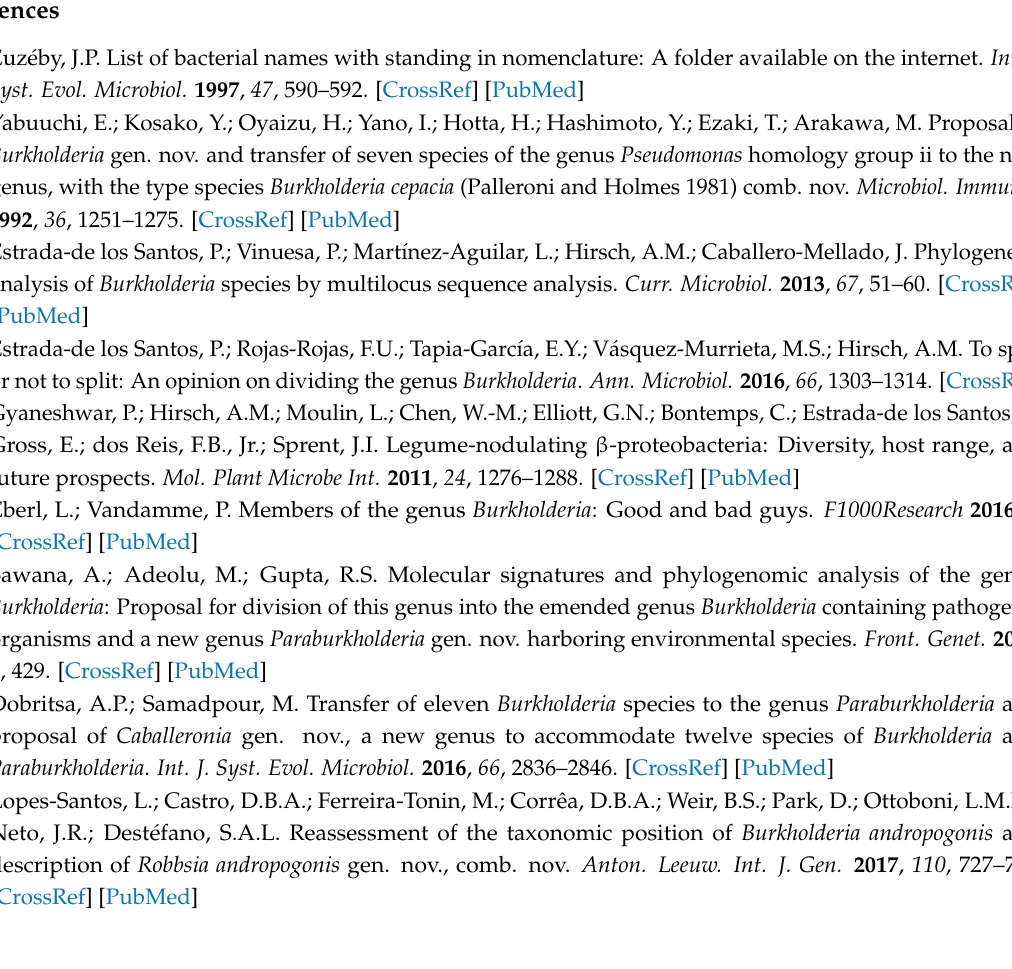
for the 122 strains used in this study of available Burkholderia (s.l.) genomes. Figure S2 : Maximum-likelihood phylogenies of Burkholderiaceae species using sequences of nifD (A) and nodB genes (B) inferred with iqTREE and using 100 nonparametric bootstrap calculations. Figure S3 : Maximum-likelihood phylogenies of Burkholderiaceae species using sequences of nodC (A) and nodD genes (B) inferred with iqTREE and using 100 nonparametric bootstrap calculations. Figure S4 : Hypersensitivity test on tobacco leaves. Figure S5 : Pathogenicity of Mycetohabitans and Trinickia strains on onion bulb scales ( Allium cepa L.) compared with bacteria known to be pathogenic ( Burkholderia cepacia 68P128). Figure S6 : Survival and growth of Caenorhabditis elegans on culture plates of Mycetohabitans and Trinickia strains compared with bacteria known to be harmless ( E. coli OP50) and pathogenic ( Pseudomonas aeruginosa PA14) to the